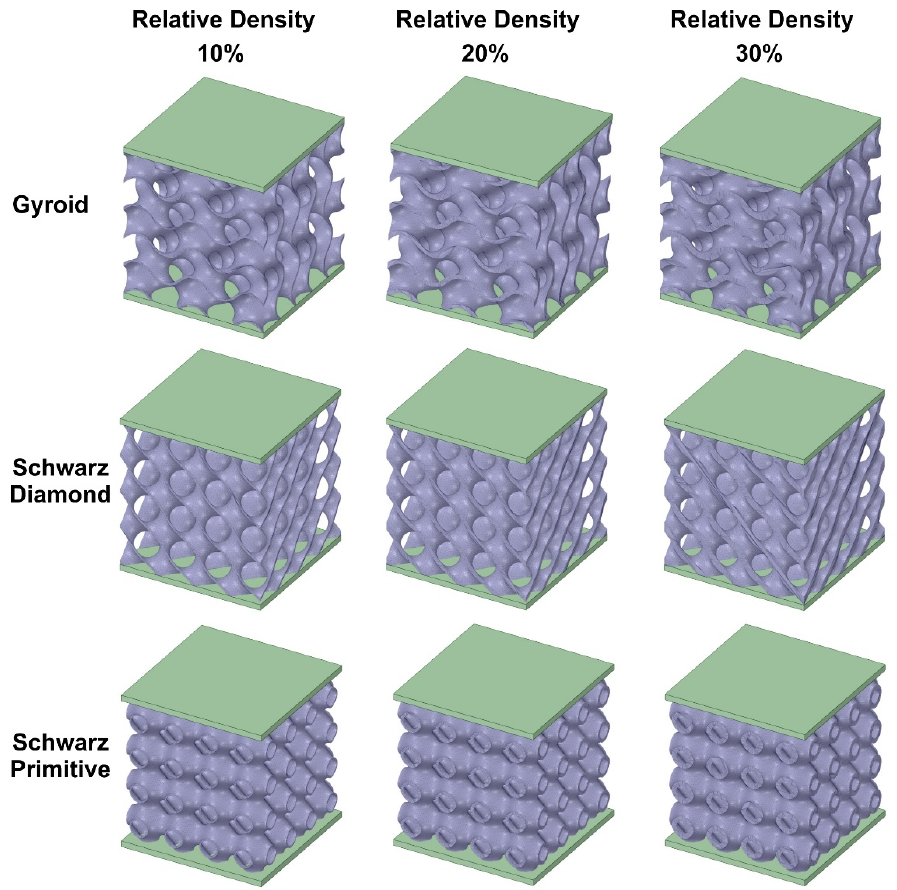
Figure 2. 3D CAD models of Gyroid, SD and SP TPMS structures (4 × 4 × 4 unit cells). Table 1. Element Thickness of Gyroid, SD and SP TPMS structures.